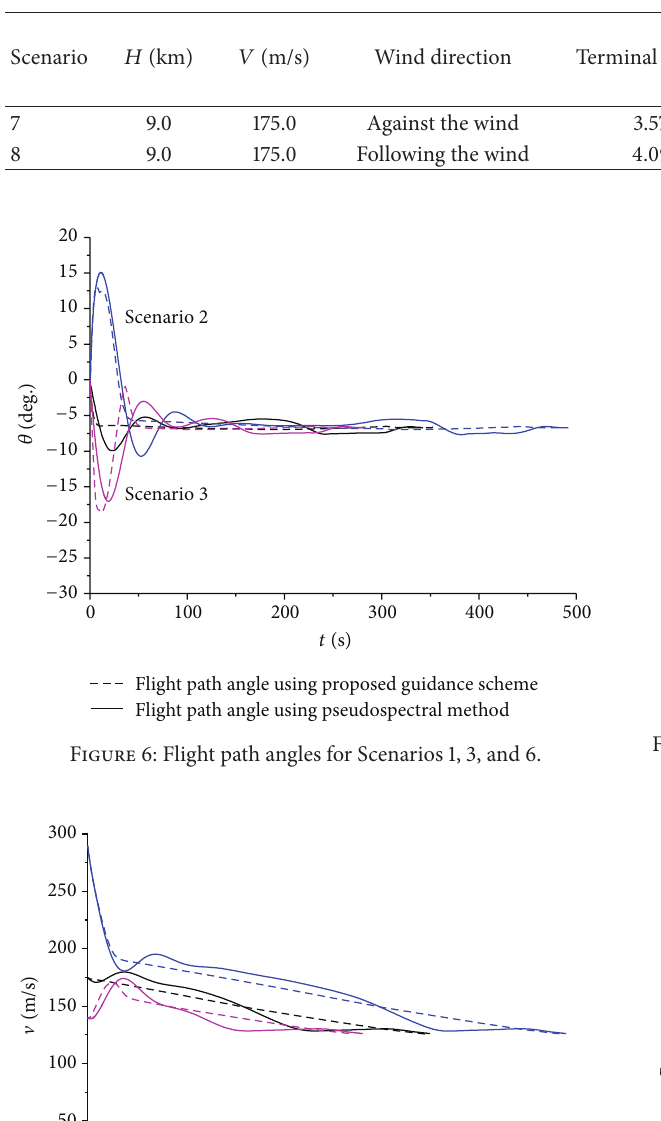
Table 5: Simulation results with wind disturbance.